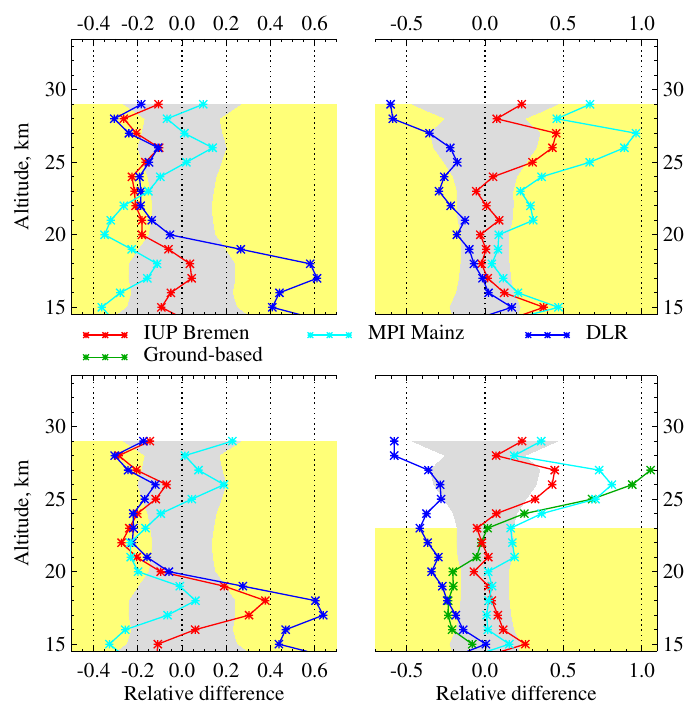
Fig. 26. Same as in Fig. 25 but for relative differences with respect to balloon-borne SAOZ results, e.g., IUP Bremen/SAOZ-1, etc.